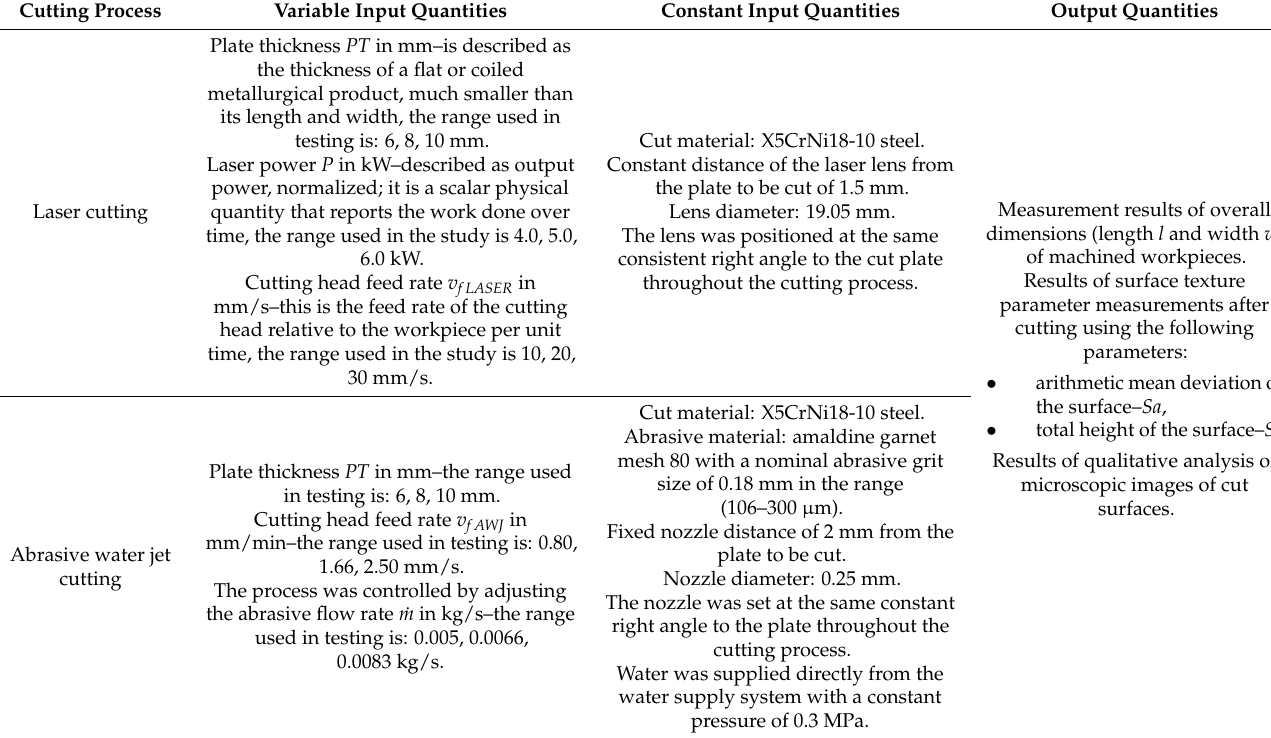
Table 1. Specification of the input quantities (constant and variable) and output quantities of the tests